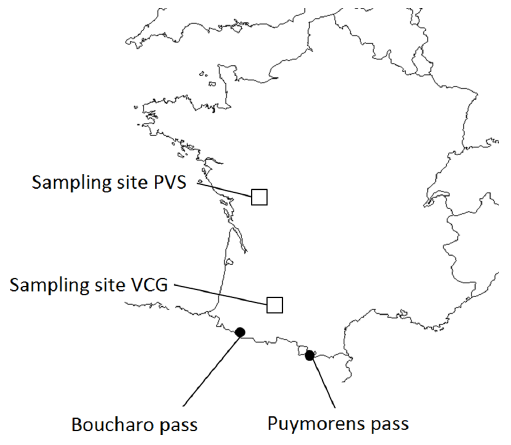
Figure 1. Sampling sites locations. Sampling sites VCG ("Valle´es et Coteaux de Gascogne"; 43 u 17 9 N, 0 u 54 9 E ) and PVS (‘‘Plaine et Val de Se`vre’’; 46 u 2 9 N,0 u 4 9 W) were sampling sites for the overwintering strategies at adult and pre-imaginal stages, Boucharo pass (42 u 42 9 13 0 N, 0 u 3 9 52 0 O) and Puymorens pass (42 u 33 9 35 0 N, 1 u 48 9 37 0 E) were sampling sites for migratory